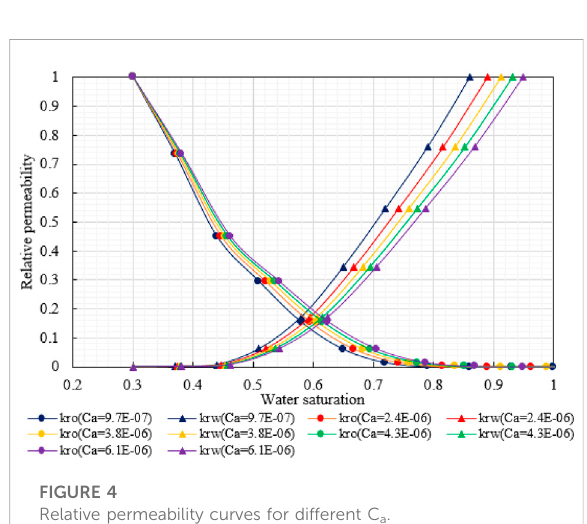
FIGURE 3 Curve of experimental data matching.